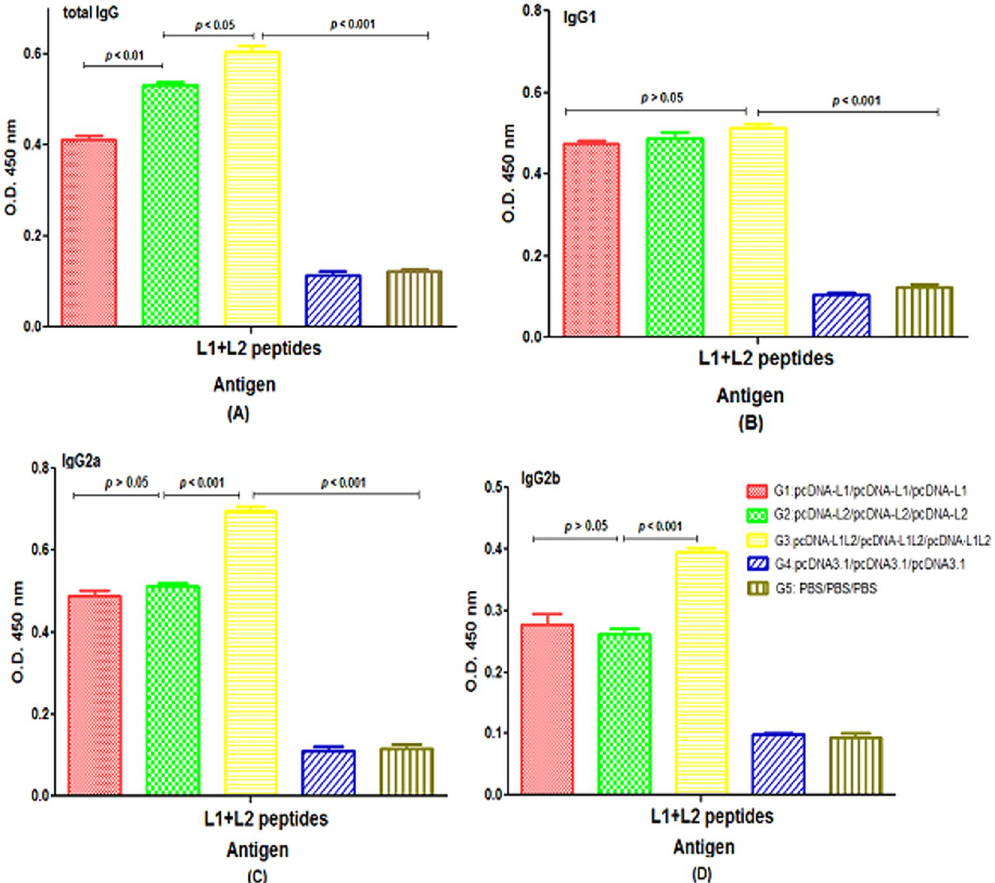
Figure 6. Antibody responses against the mixture of L1 + L2 peptides as an antigen in different groups: ( A ) total IgG, ( B ) IgG1, ( C ) IgG2a and ( D ) IgG2b; Mice sera were prepared from the whole blood samples of each group (n = 6) two weeks after the last immunization. All analyses were performed in duplicate for each sample shown as mean absorbance at 450 nm ±